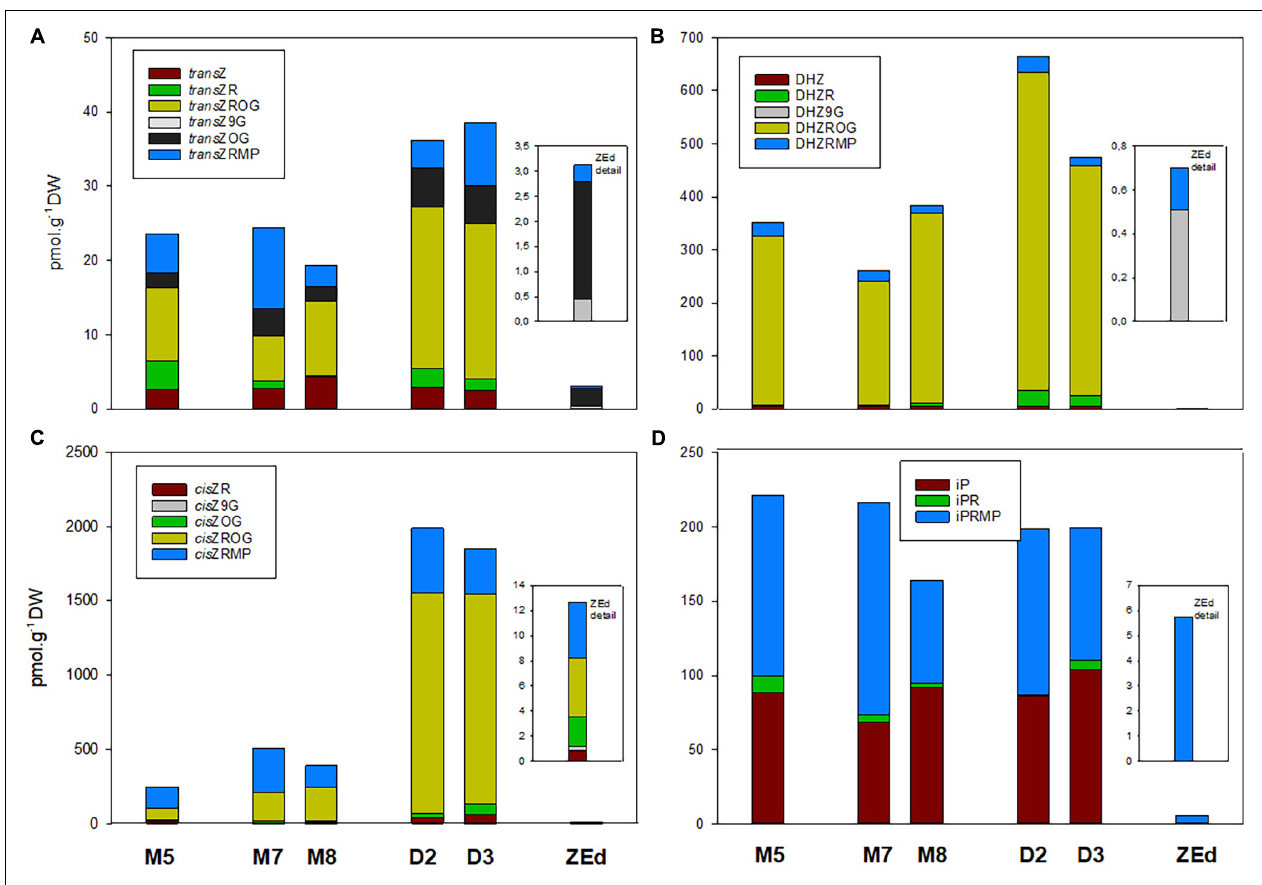
FIGURE 9 | Content of individual cytokinins and their derivatives in P. abies somatic (SEs) and zygotic (ZEs) embryos. (A) Trans -zeatin types: trans Z, trans -zeatin; trans ZR, trans -zeatin 9-riboside; trans ZOG, trans -zeatin O -glucoside; trans ZROG, trans -zeatin 9-riboside O -glucoside; transZRMP, trans -zeatin 9-riboside-5 (cid:48) -monophosphate. (B) Dihydrozeatin types: DHZ, dihydrozeatin; DHZR, dihydrozeatin 9-riboside; DHZ9G, dihydrozeatin-9-glucoside; DHZROG, dihydrozeatin 9-riboside O -glucoside; DHZRMP, dihydrozeatin 9-riboside-5 (cid:48) -monophosphate. (C) Cis -zeatin types: cis ZR, cis -zeatin 9-riboside; cis ZOG, cis -zeatin O -glucoside; cis Z9G, cis -zeatin 9-glucoside; cis ZROG, cis- zeatin 9-riboside O -glucoside; cis ZRMP, cis -zeatin 9-riboside-5 (cid:48) -monophosphate. (D) N 6 -( (cid:49) 2 -isopentenyl) adenine types: iP, N 6 -( (cid:49) 2 -isopentenyl) adenine ; iPR, N 6 -( (cid:49) 2 -isopentenyl) adenosine; iPRMP, N 6 -( (cid:49) 2 -isopentenyl) adenosine-5 (cid:48) -monophosphate. M5 – mature SEs after 5 weeks of maturation, M7 and M8 – SEs after 7 and 8 weeks of prolonged maturation, D2 and D3 – SEs after 2 and 3 weeks of desiccation, ZEd – dry